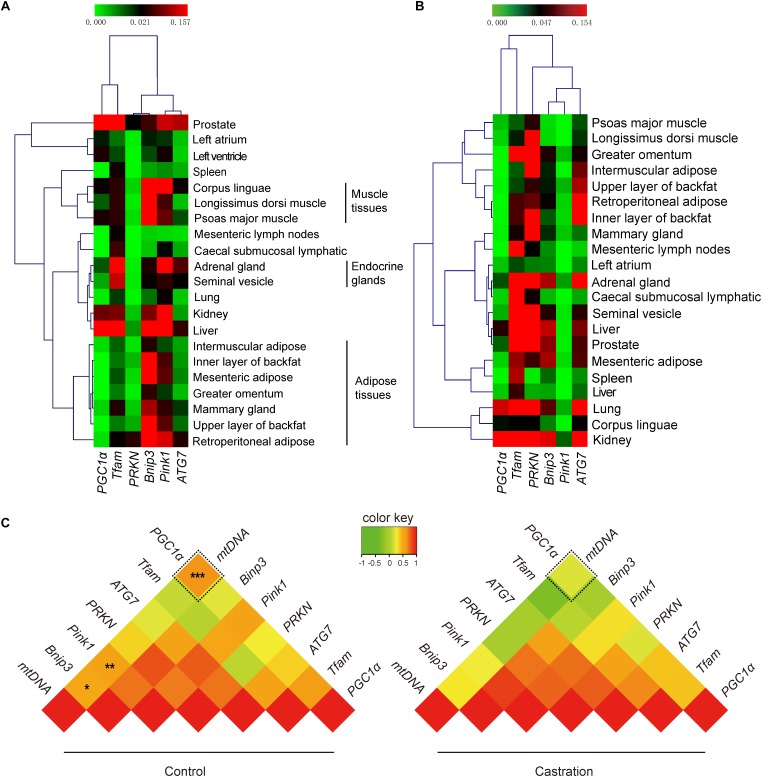
Tissue expression profiling of mitochondrial homeostasis-associated genes. The mRNA expression of PGC1a, TFAM, ATG7, PRKN, Pink1, and Bnip3 and mtDNA copy numbers in various tissues. Hierarchical clustering analysis for the mRNA expression of mitochondrial biogenesis-associated genes in 21 tissues in (A) control pigs and (B) castrated pigs. (C) Correlation analysis of mitochondrial biogenesis and mitochondrial autophagy-associated genes with mtDNA copy number. Values represent the correlation coefficient (r) based on Spearman’s rank correlation analysis. All data are expressed as means ± SD, n = 4 in each group. Tukey’s post hoc test, ∗P < 0.05, ∗P < 0.01, ∗∗∗P < 0.001.